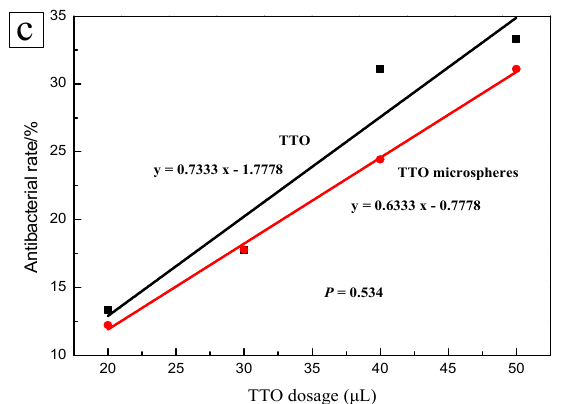
Figure 6. ( a ) Inhibition zones of TTO at various dosages 20 μ L ( a 1 ), 30 μ L ( a 2 ), 40 μ L ( a 3 ), and 50 μ L ( a 4 ) for 24 h; ( b ) inhibition zones of TTO microspheres at various dosages 20 μ L ( b 1 ), 30 μ L ( b 2 ), 40 μ L ( b 3 ), and 50 μ L ( b 4 ) for 24 h; and ( c ) anti-bacterial rate of TTO and TTO microspheres at various dosages.